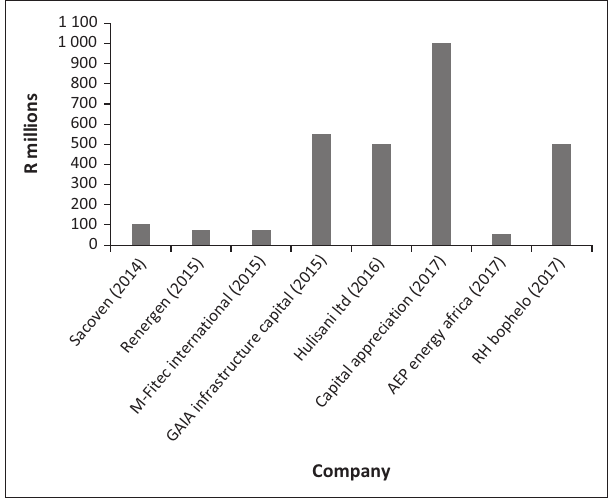
FIGURE 1: Capital raised (R